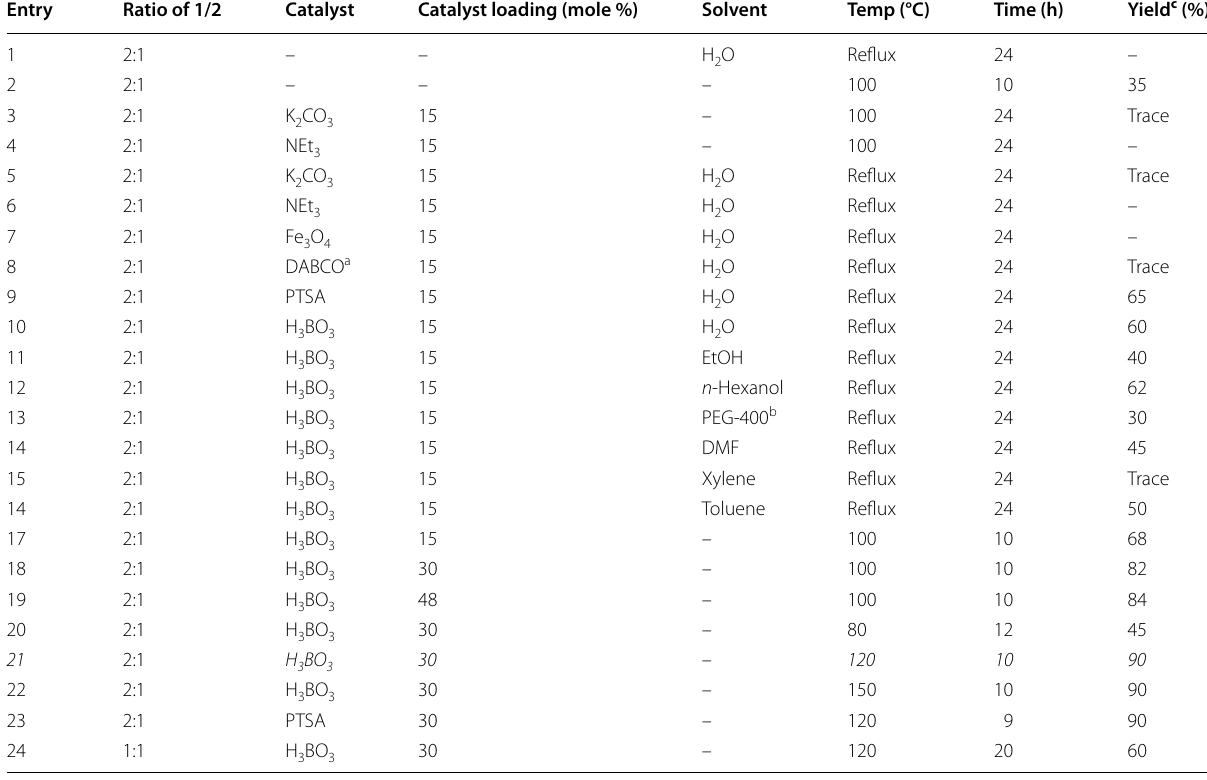
Table 1 Optimization of the reaction conditions for the synthesis of